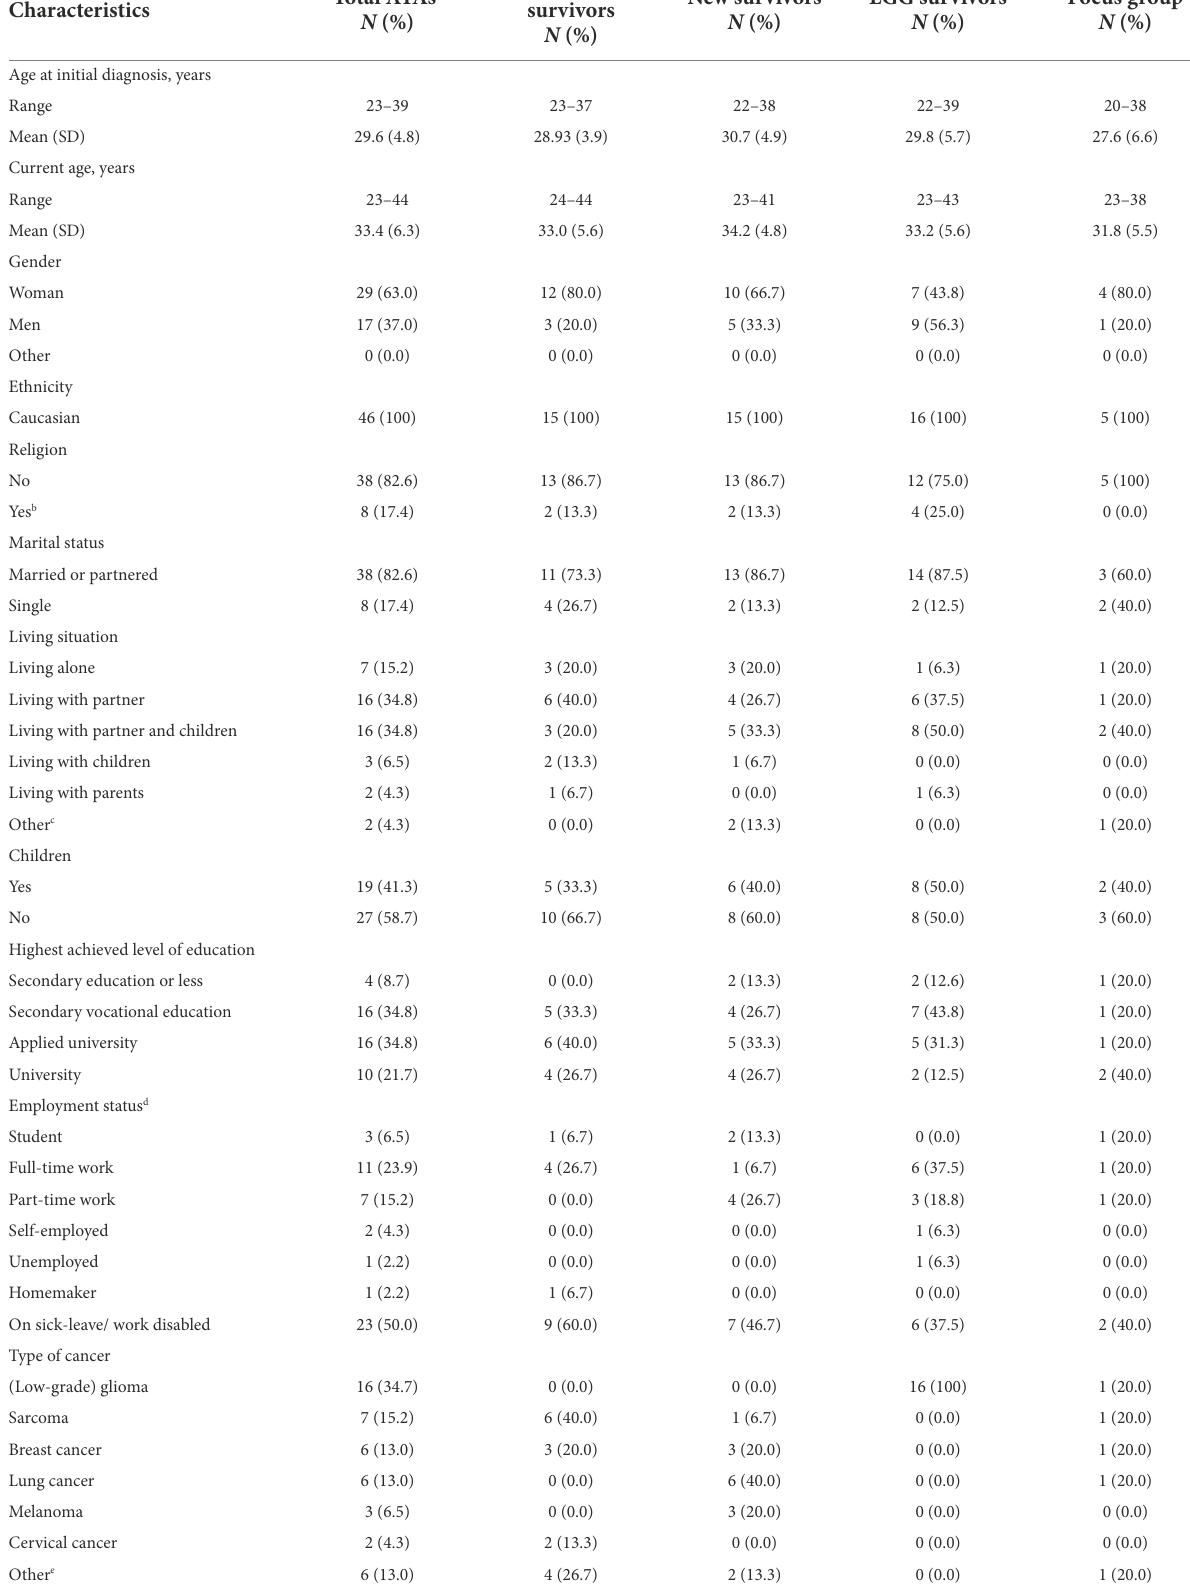
TABLE 2 Demographics of AYA respondents and focus group